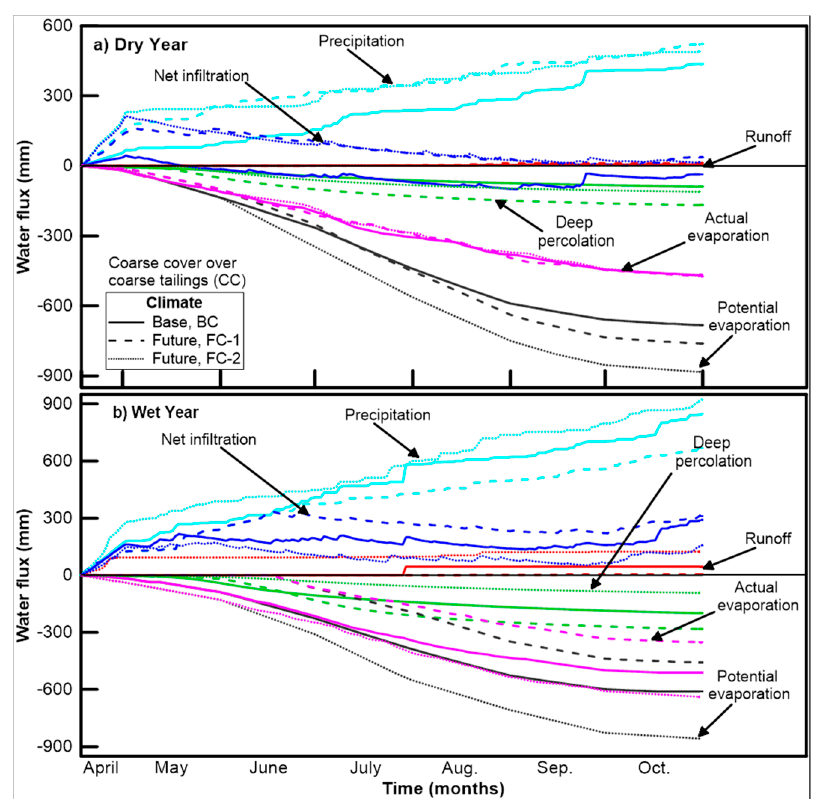
Figure 7. Water balance at the ground surface and at the tailings–cover interface for homogeneous coarse profile, CC for ( a ) dry year; ( b ) wet year.